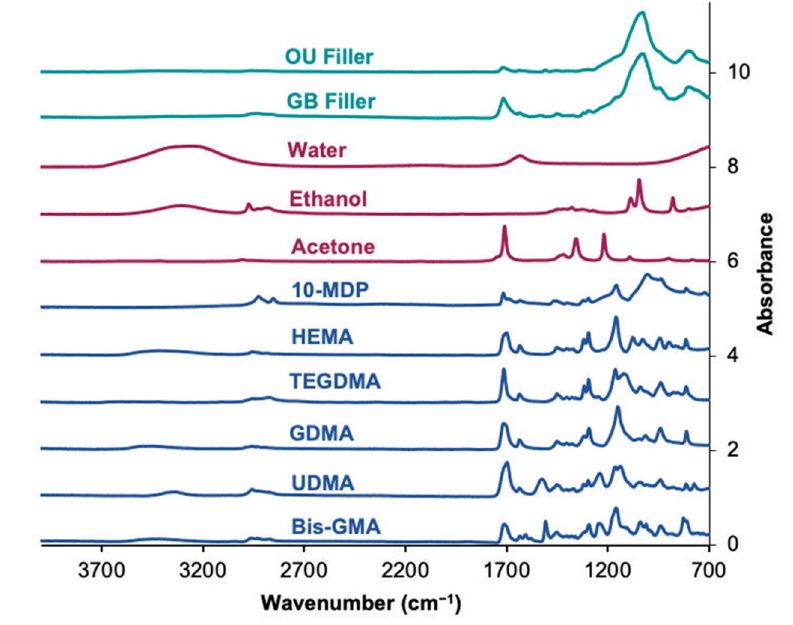
Figure 2. ATR–FTIR spectra of the individual fillers, solvents and monomers acquired to build the model fitting. Common and distinct peak assignments are provided in Table 2. Table 2. Peak assignments of the individual monomers (10-MDP, Bis-GMA, GDMA, HEMA, TEGDMA, and UDMA) or solvents (acetone, ethanol, and water) depicted in Figure 3. Left side shows common methacrylate peaks, transversal to all monomers used, whereas right side of the table depicts distinct peak assignments found in selected